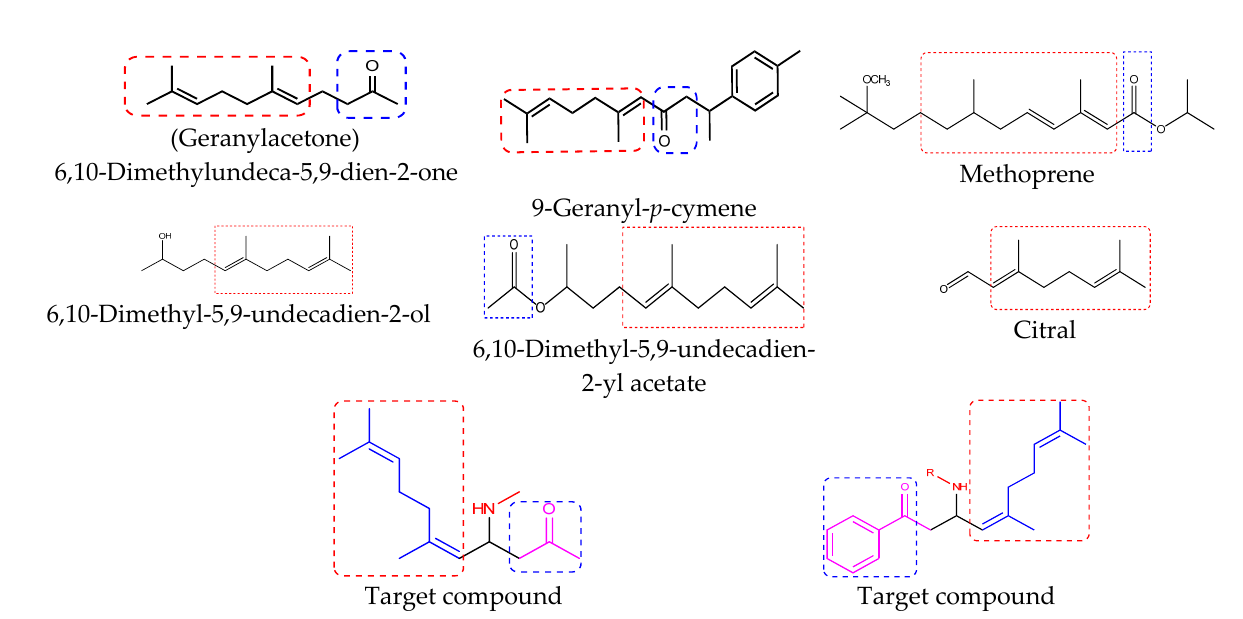
Figure 1. Undeca-5,9-dien-1-one (Geranylacetone derivatives). 9-(15,16-Dihydro-15-methylene)-geranyl- p -cymene and 9-(15,16-dihydro-15–meth- ylene) -geranyl- α -terpinene were first identified in the essential oils of the flowers of